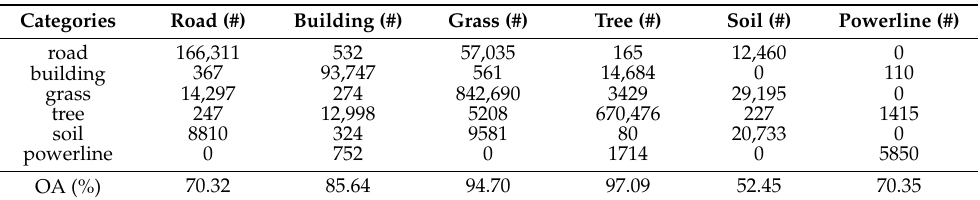
Table 3. The point cloud classification confusion matrix of the SE-PointNet++, (# represents the number of the